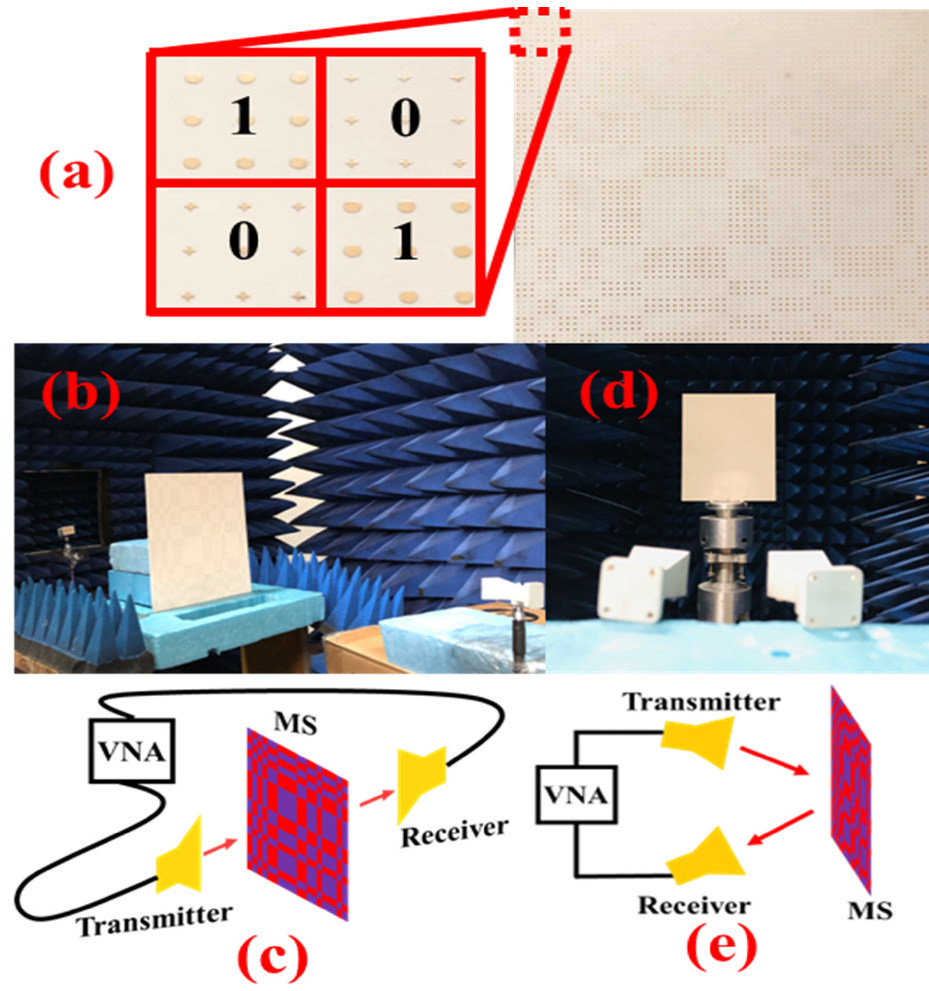
Figure 7. Fabrication and experimental arrangement. ( a ) Fabricated prototype. ( b , c ) Experimental and schematic setup of measuring transmission and ( d , e ) for reflection.